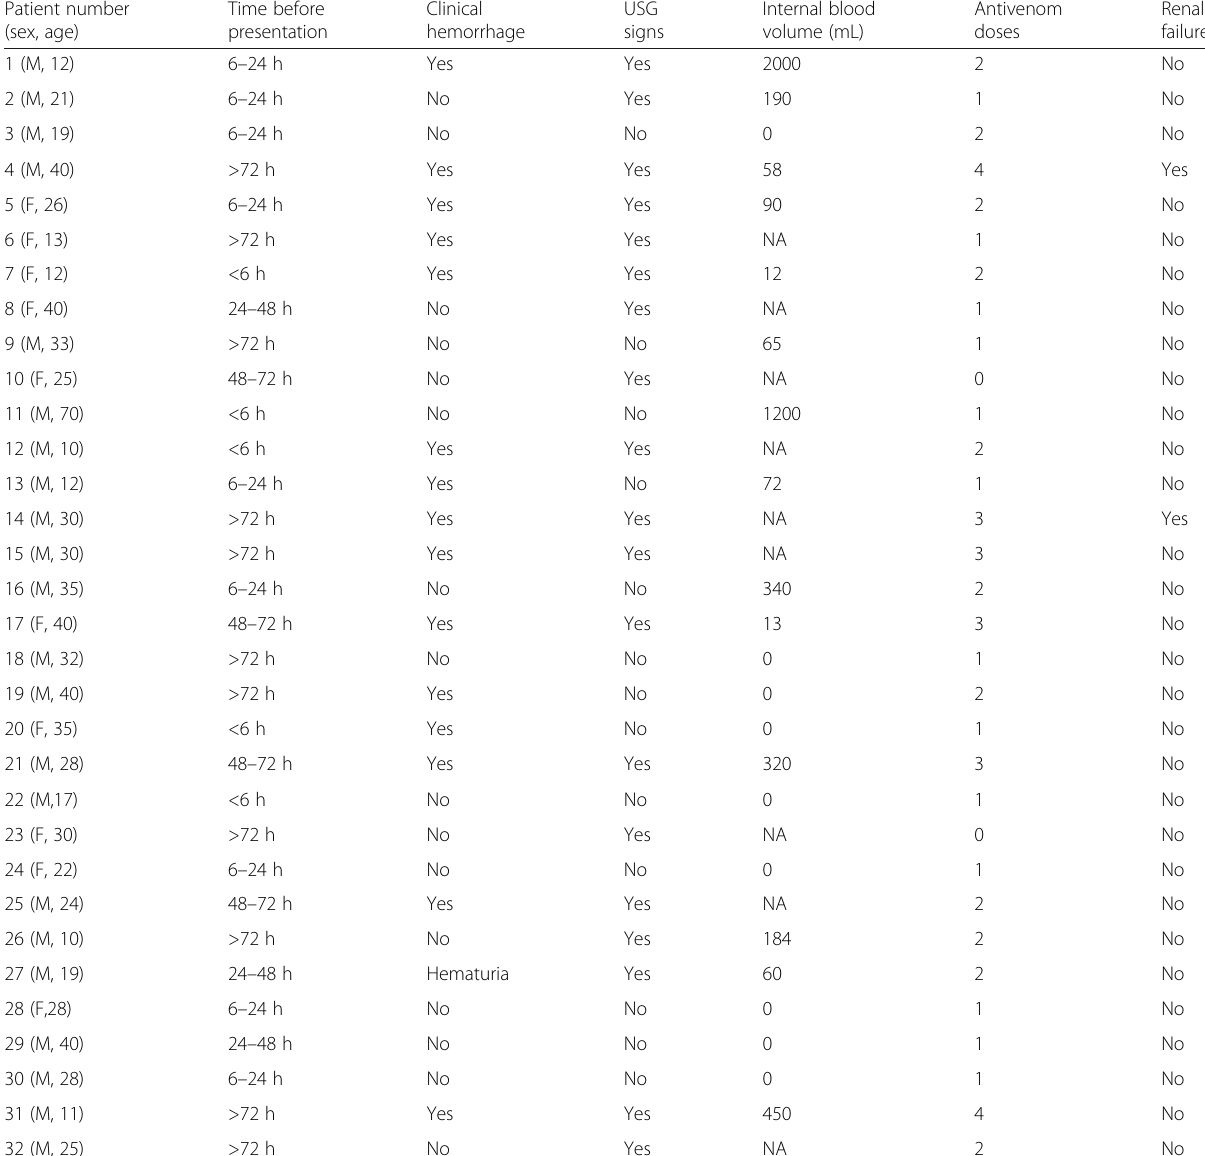
Table 1 Individual data regarding clinical bleeding, ultrasonography imaging, renal failure and treatment ( NA = not available) Patient number (sex, age)